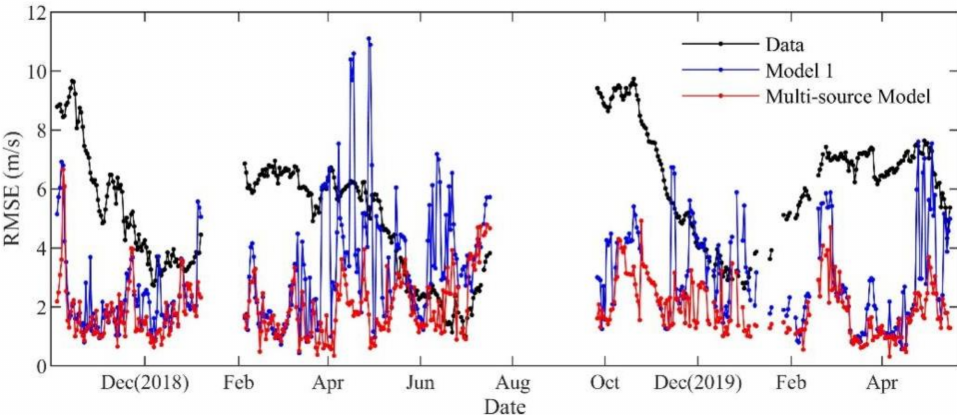
Figure 4. Deviations in the data and estimation errors for different samples.